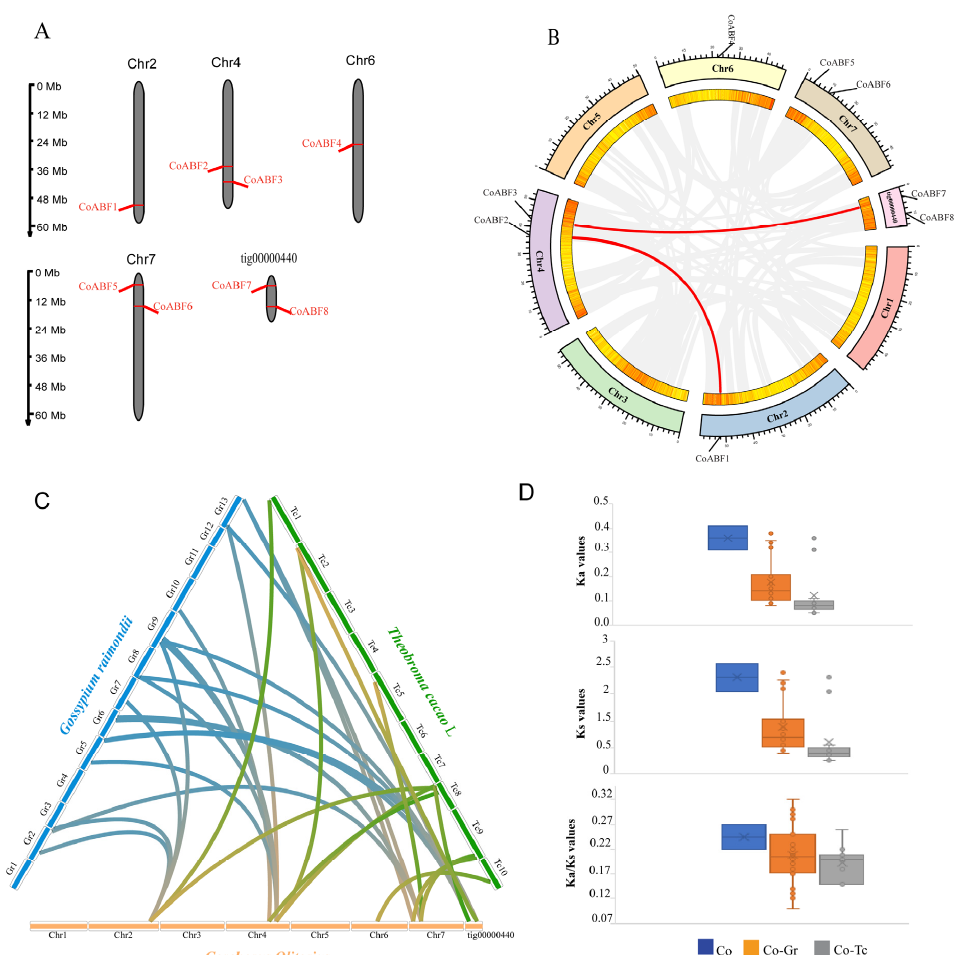
Figure 3. Schematic representations for chromosomal location and synteny analysis analyzed for CoABF genes. ( A ) The chromosome (Chr) numbers are exhibited above each chromosome, while the CoABF genes are located on the right or left side of the chromosome. The scale bar on the left indicates chromosome length (Mb). ( B ) Segmental duplication of CoABF genes in the jute genome was analyzed by gene duplication analysis. Gray lines indicate all synteny blocks in the C. olitorius genome and red lines indicate duplicated CoABF gene pairs. ( C ) Synteny analysis between CoABF genes and T. cacao and G. raimondii genomes. The orange–green lines indicate the relationship between C. olitorius and T. cacao , while the orange–blue lines represent the relationship between C. olitorius with G. raimondii. ( D ) Ka, Ks, and Ka/Ks ratios of duplicated genes. The box plots represent the average and median values of the Ka, Ks, and Ka/Ks values, respectively. Co: C. olitorius ; Gr: G. raimondii ; Tc: T. cacao